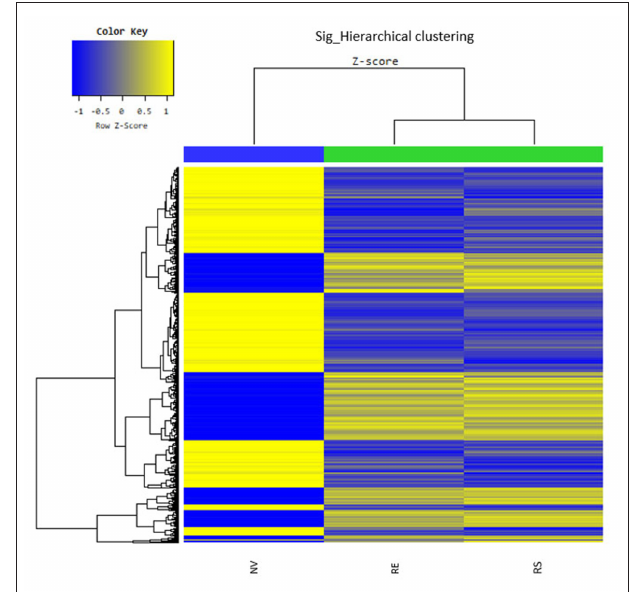
FIGURE 6 | The hippocampal effects of 4 weeks of voluntary wheel exercise-induced EVs. The microarray hierarchical clustering heat-map image. NV, non-restrained vehicle-injected group ( n = 3); RS, restraint-stressed sedentary EV-injected group ( n = 4); RE, restraint-stressed exercise EV-injected group ( n =